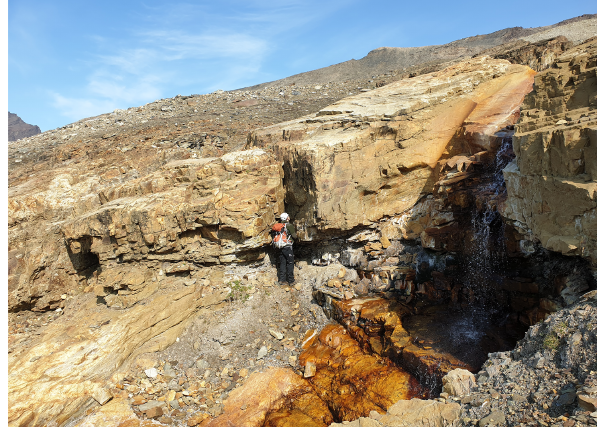
Figure 3. Field photo of the bedrock geology of the coastal slope 1.5km west of area 1. View is towards the west. Sub-vertical joint- ing and s0 foliation dipping 20–30 ◦ towards the fjord are promi- nent. The geologist is standing next to a vertical open fracture with a small normal offset (20–30cm) apparent on the surface that could be a model for the development of the back scarp of the rock avalanches. Photo by Simon Mose Thaarup,